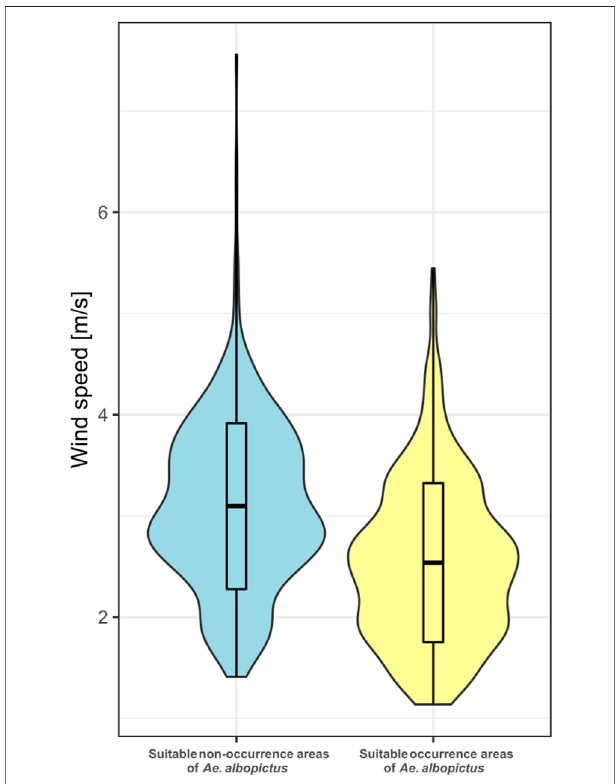
FIGURE 4 | Differences in wind speed (ms − 1 ) between occurrence and non-occurrence areas of Aedes albopictus within its climatic niche in Europe based on the 5-percentile thresholded ecological niche model ( Model-with- wind-speed , Supplementary Figure S2b ). Mean, minimum, and maximum wind speeds in the suitable non-occurrence areas are signi fi cantly higher than those in the suitable occurrence areas.